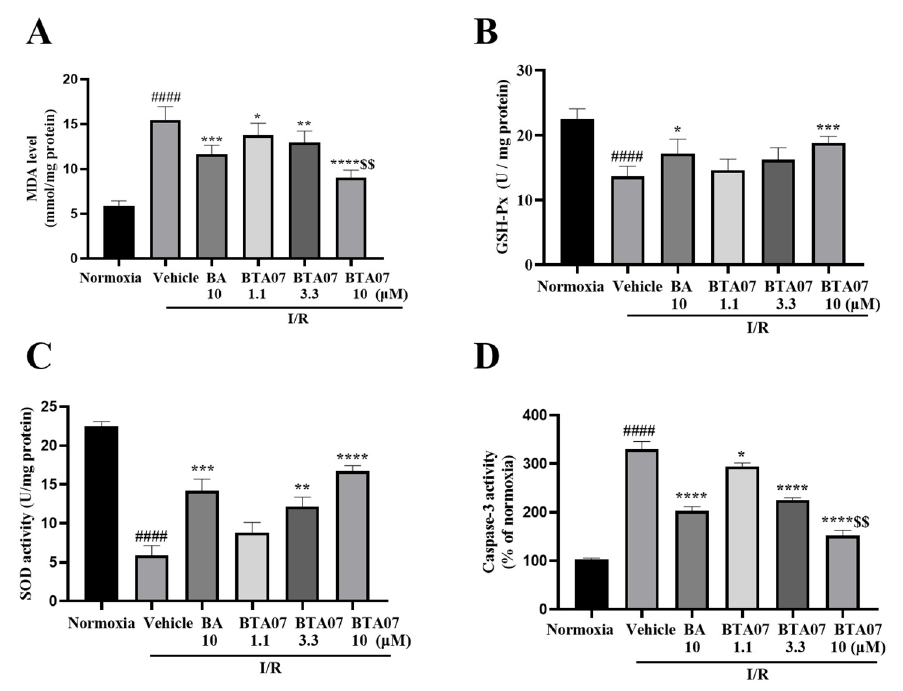
Figure 4. BTA07 treatment suppressed I/R − induced oxidative potential and apoptosis in cardiac tissue. ( A ) Levels of malondialdehyde (MDA). ( B ) Glutathione peroxidase (GSH-Px). ( C ) Superoxide dismutase (SOD). ( D ) Caspase-3 activity in the isolated rat heart preparation was detected in the myocardial homogenate of isolated hearts after reperfusion. Data are presented as means ± S.E.M for five independent experiments. #### p < 0.0001 vs. normoxia group; **** p < 0.0001 vs. vehicle group; *** p <0.001vs. vehicle group; ** p <0.01vs. vehicle group; * p < 0.05 vs. vehicle group; $$ p < 0.01vs.